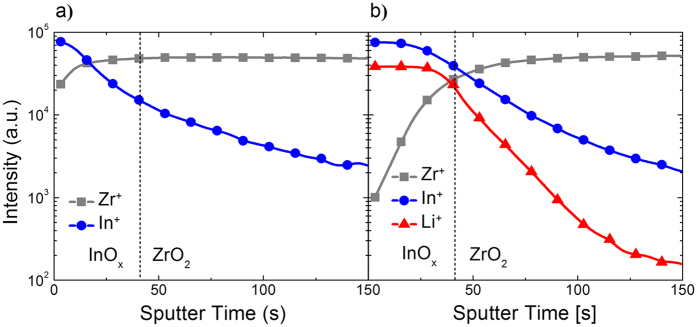
Depth profile of Li, In, and Zr cations for the In2O3/ZrO2 stack annealed at 250 °C with different Li+ loadings.(a) 0 and (b) 13.5 mol%.